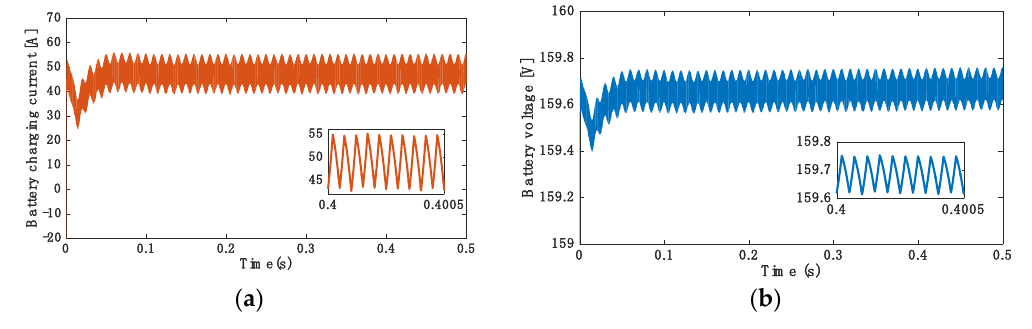
Figure 18. G2V: ( a ) Battery charging current; ( b ) Battery voltage.